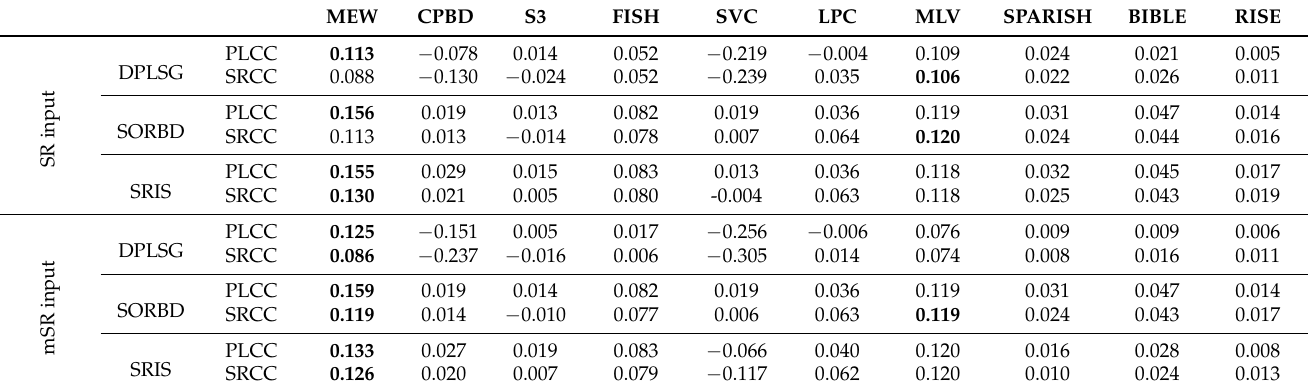
Figure 6. Absolute score difference in each image in LIVE based on the SORBD method and the MEW model. Beside the points of the three largest score drops, the corresponding images are illustrated. (The figure can be enlarged for viewing). Table 2. Center region (CR) input as the baseline for BISA comparison on the